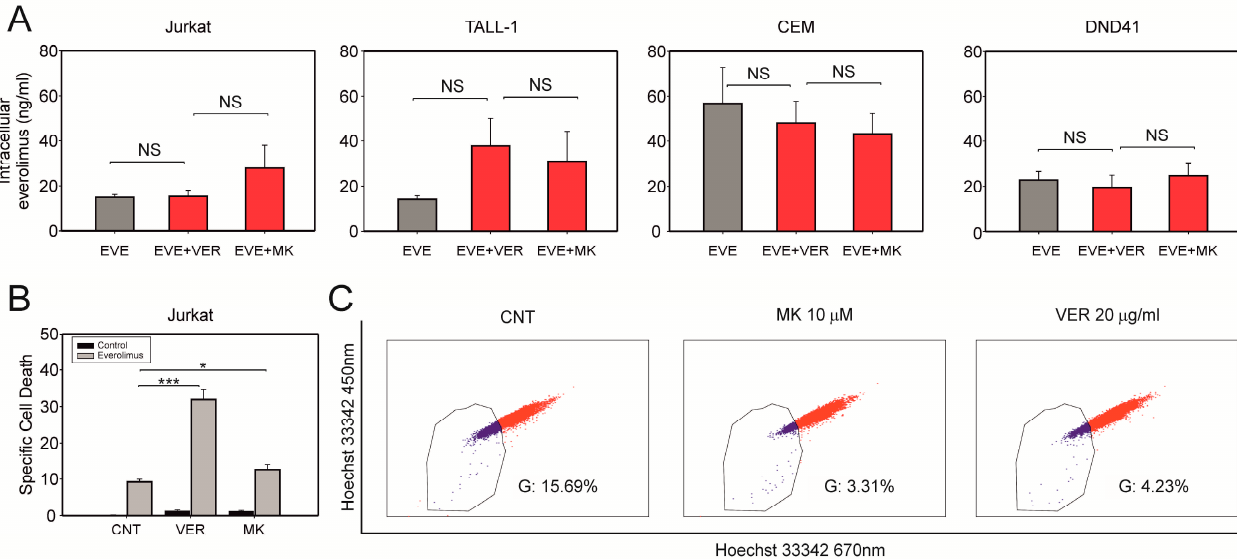
Figure 3. In vitro effects of MDR inhibitors. ( A ) Quantification of everolimus in the four T-ALL cell lines treated with everolimus (EVE, 10 μ M) alone, or in combination with MK 571 (10 μ M) or verapamil (VER, 20 ng/mL). Everolimus was quantified by MRM-MS and the 4000 QTrap system. ( B ) Specific cell death after a 24-hour treatment with verapamil (20 ng/mL) or MK 571 (10 μ M) combined with EVE (10 μ M); mean values and standard error bars are shown. The indicated pairwise comparisons were statistically significant with the Mann-Whitney test; *** indicate p values < 0.001, * < 0.05, NS = not significant. ( C ) Inhibition of Hoechst 33342 efflux by verapamil and MK 571. Dot blots show blue and red fluorescence (emission at 450 and 670 nm, respectively) of Jurkat cells stained with the MDR substrate Hoechst 33342 (8 μ M) after a 30-minute treatment with MDR inhibitors. The three graphs report percentages of cells with low fluorescence levels (i.e., those that have excluded the dye) measured in the same arbitrary gate.